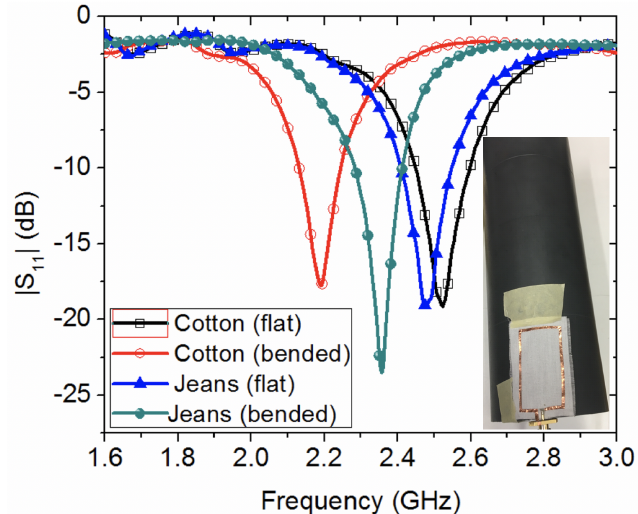
Figure 11. Experimental study of the effect of bending two wearable loop antenna prototypes, oriented parallel to the longitudinal axis of a cylindrical PVC